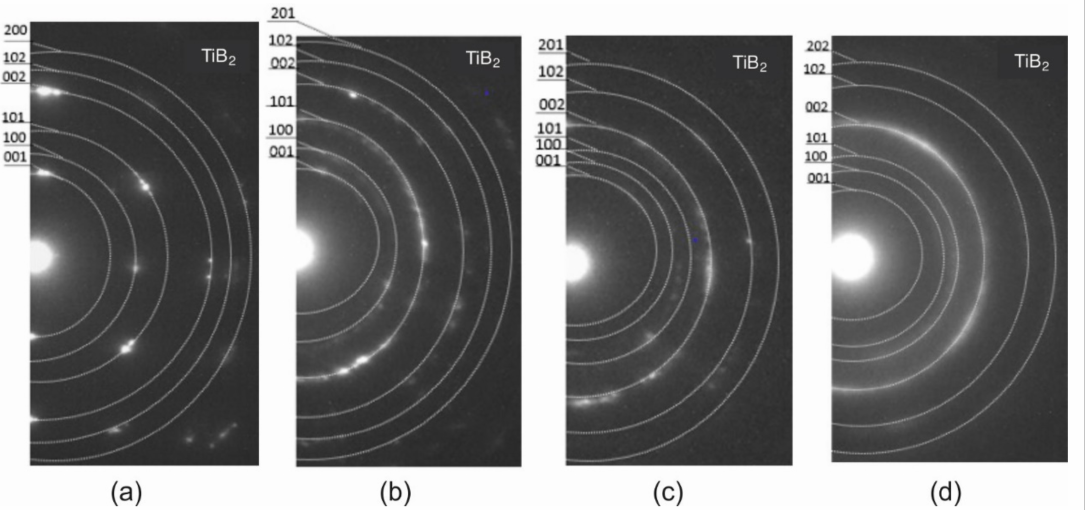
Figure 3. SAED patterns indicating TiB 2 as the only phase ( a ) TiB 2 ; ( b ) Ti 0.78 W 0.22 B 2 ; ( c ) Ti 0.58 W 0.42 B 2 ; and ( d ) Ti 0.5 W 0.5 B 2